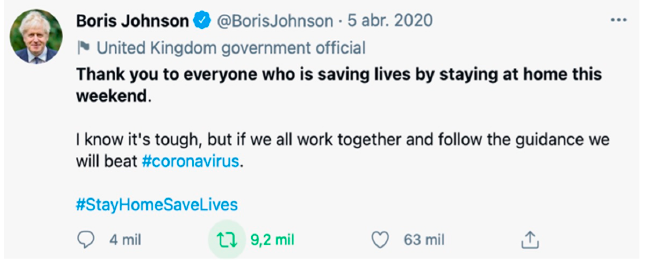
Figure 9. Example of sample content 3.